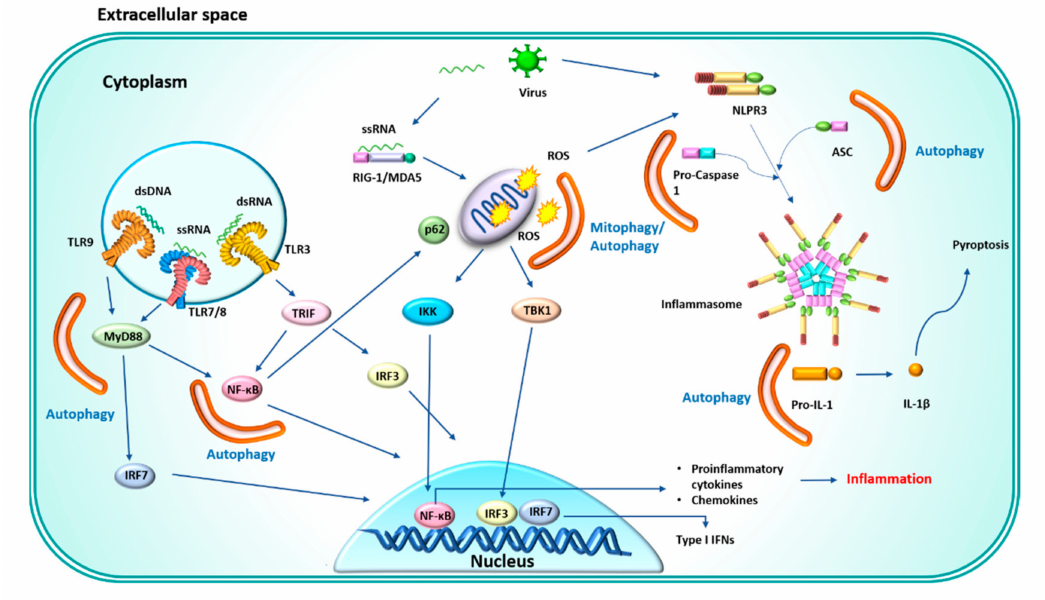
Figure 3. Regulation of inflammation by autophagy. The principal points downstream of proinflammatory cytokine signaling that can be potentially regulated by autophagy are indicated. The proinflammatory response might be regulated by autophagic degradation of pivotal molecules like MyD88, the nuclear factor kB (NF- κ B) and depolarized mitochondria and ROS. Moreover, autophagy can regulate IL-1 β production via the removal of ASC pyroptosome, pro-caspase 1 and